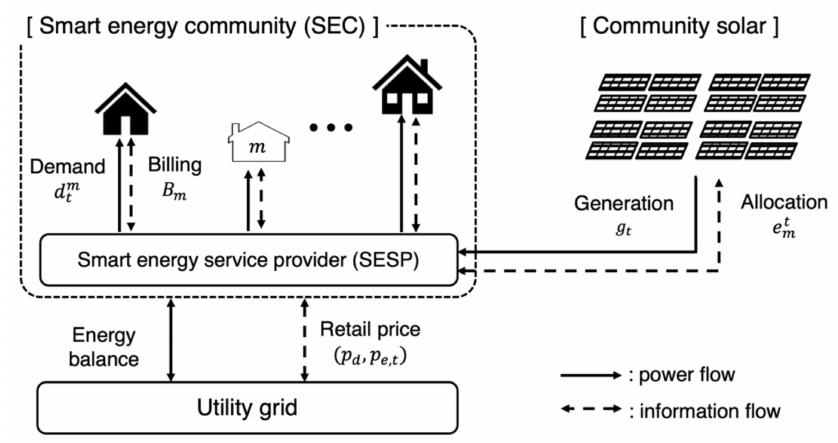
Figure 2. Constitution of a community solar system for a smart energy